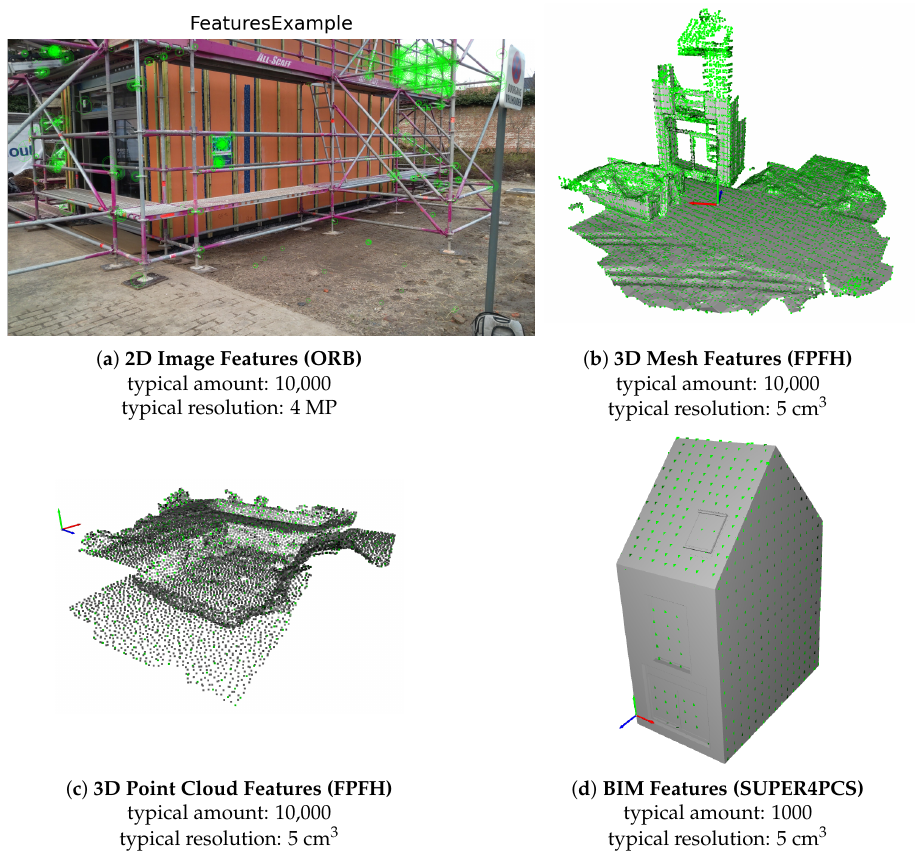
Figure 3. Overview of the different types of data with their respective features for geolocalisation.